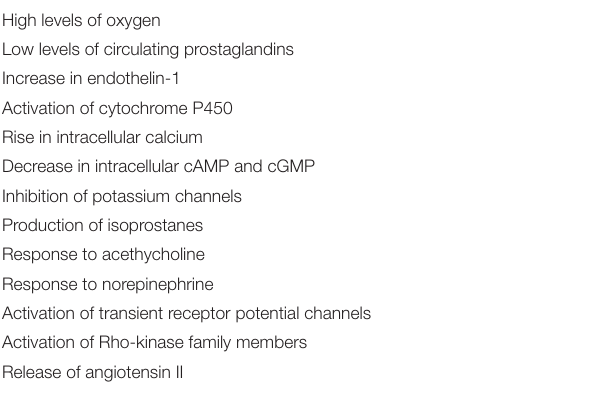
TABLE 2 | Factors that contribute to ductal constriction after